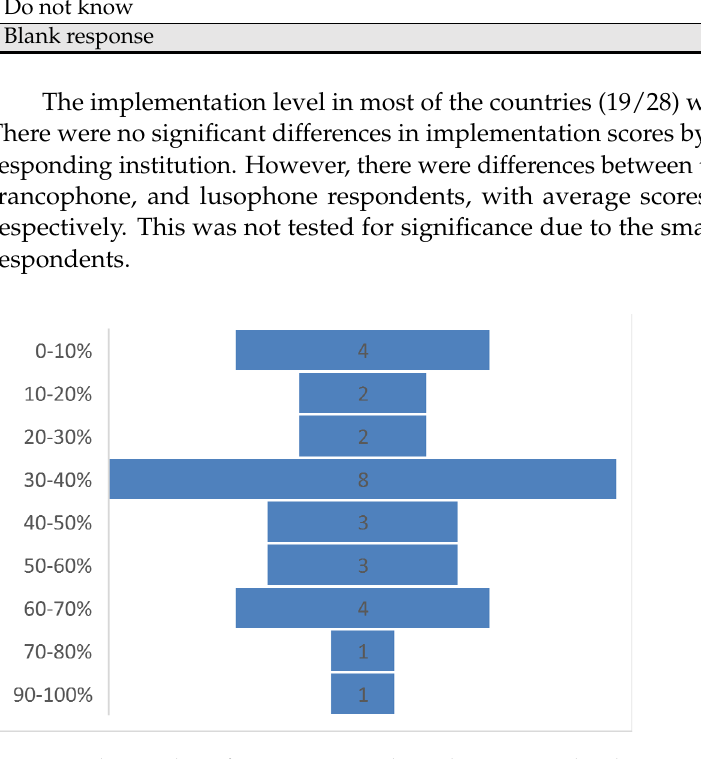
Figure 5. Implementation score by each IASC recommendation. 3.2. Qualitative Results Seventeen in-depth interviews were carried out with participants from 12 countries. The evidence generated through the qualitative data collection and analysis highlighted some key challenges and opportunities for mental health in the context of emergencies, which we outline below. 3.2.1. Challenges to Improving MHPSS Components in Crisis Response Lack of Political Commitment and Engagement Almost all participants felt there was a lack of engagement and interest in mental health—both before and at the outset of the COVID-19 pandemic. Participants described